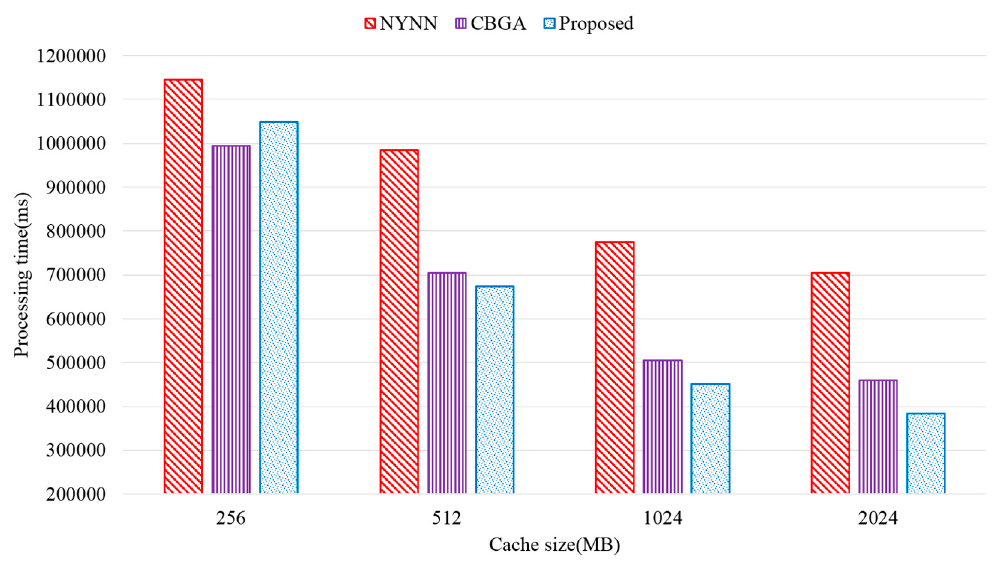
Figure 13. Processing time according to memory size.